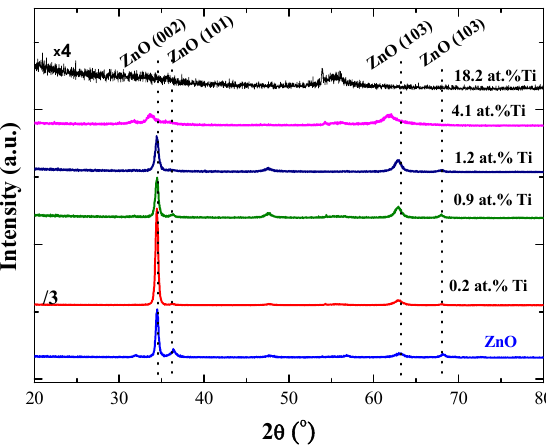
Figure 3. The X-ray spectra of Ti-incorporated ZnO (TZO) films with different Ti content. (Notice that the intensity of the sample with a Ti content at 0.2 at.% is divided by 3, whereas the sample with 18.2 at.% Ti is multiplied by 4.).